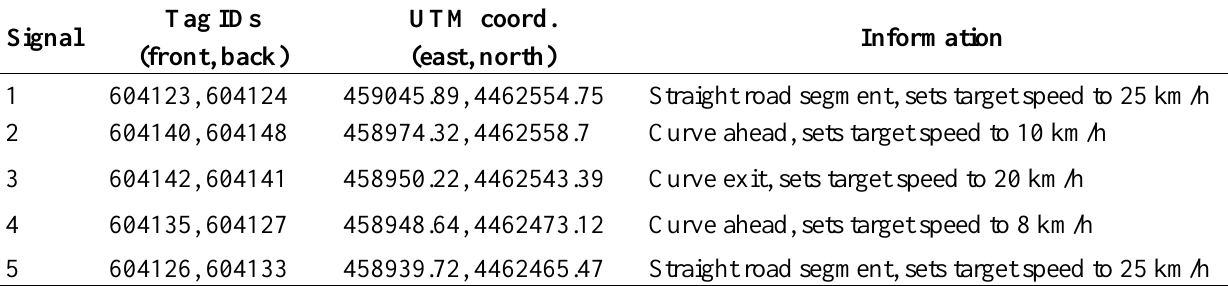
Table 1 : description of the traffic signals used in the circuit of Figure 6. Their position was accurately determined with the GPS system.